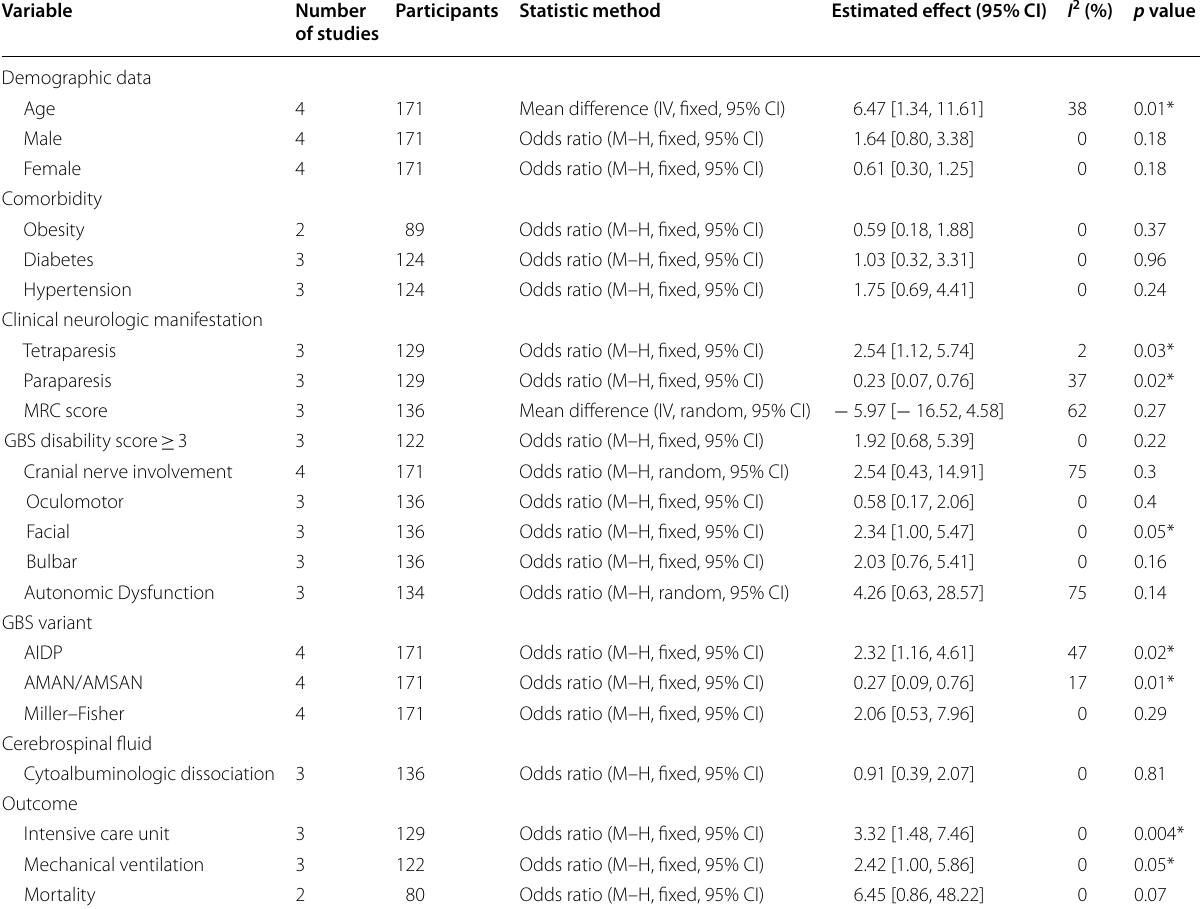
Table 3 Meta-analysis of clinical characteristics of GBS in